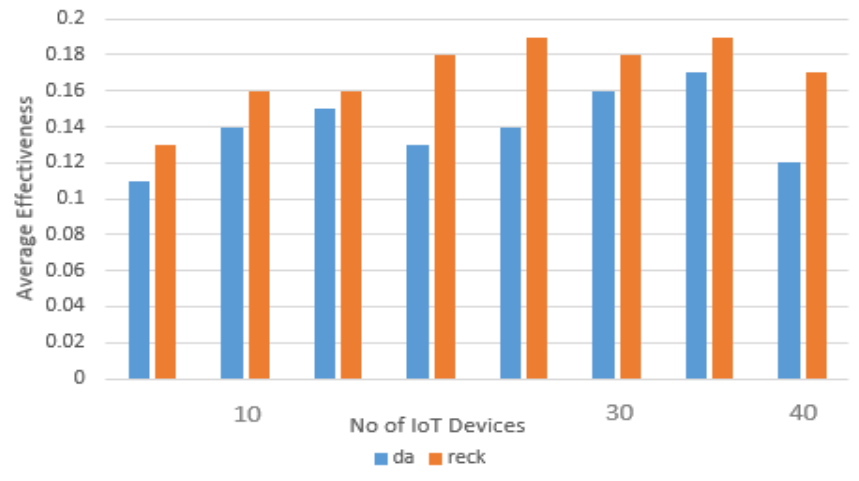
Figure 5. Comparative analysis of DA and RECK algorithm in the context of average